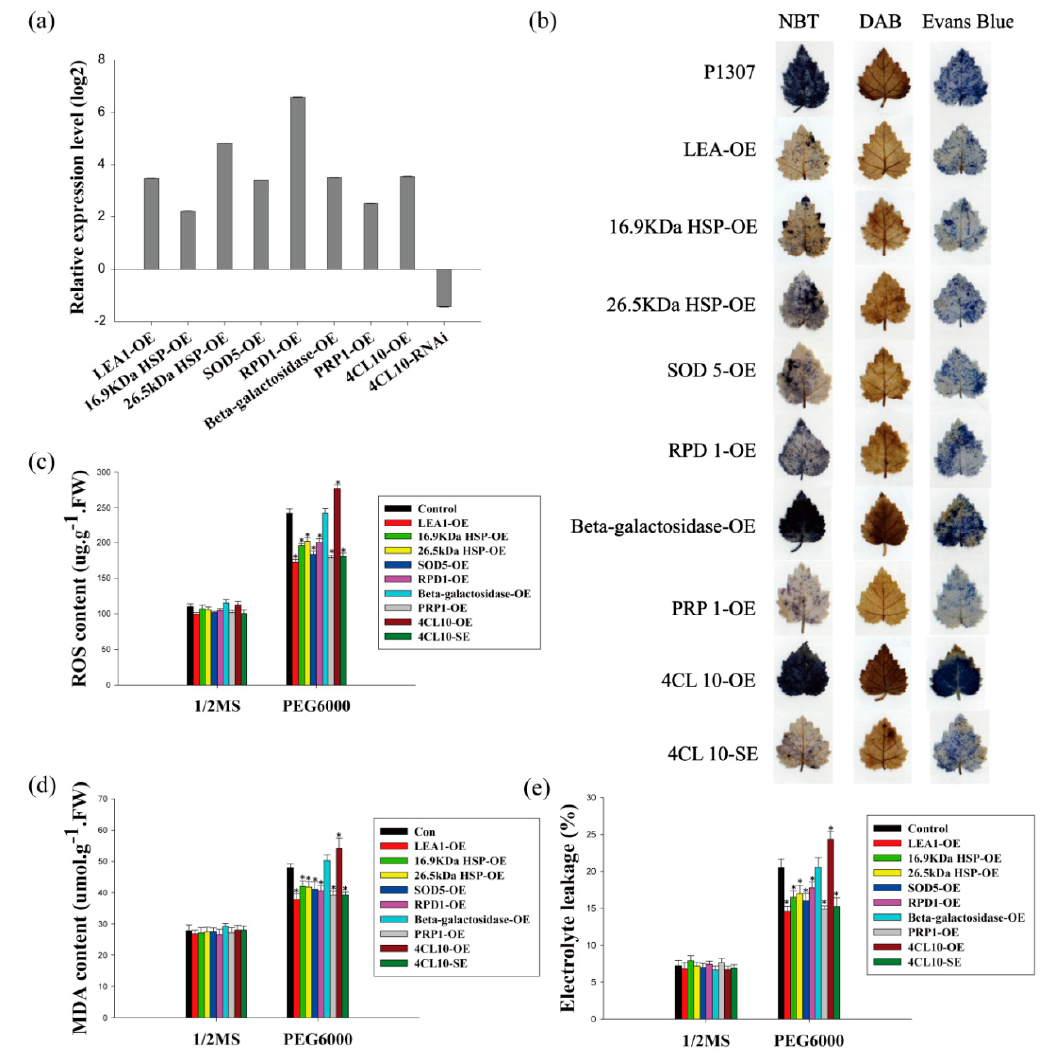
Figure 6. Analysis of the drought stress tolerance of several BpERF2 or BpMYB102 target genes. The plants were transiently transformed with several target genes of BpERF2 and BpMYB102 for overexpression, and empty p1307-myc was transiently transformed into plants as the control. ( a ) Analysis of the expression of the transgenes in transiently transformed plants using qRT-PCR. ( b ) NBT, DAB, and Evans blue staining analysis. ( c – e ) Comparison of ROS content ( c ), MDA content ( d ), and electrolyte leakage ( e ) among the studied plants under normal or drought stress conditions. Asterisks indicate a significant difference between treatment and control plants ( p < 0.05).